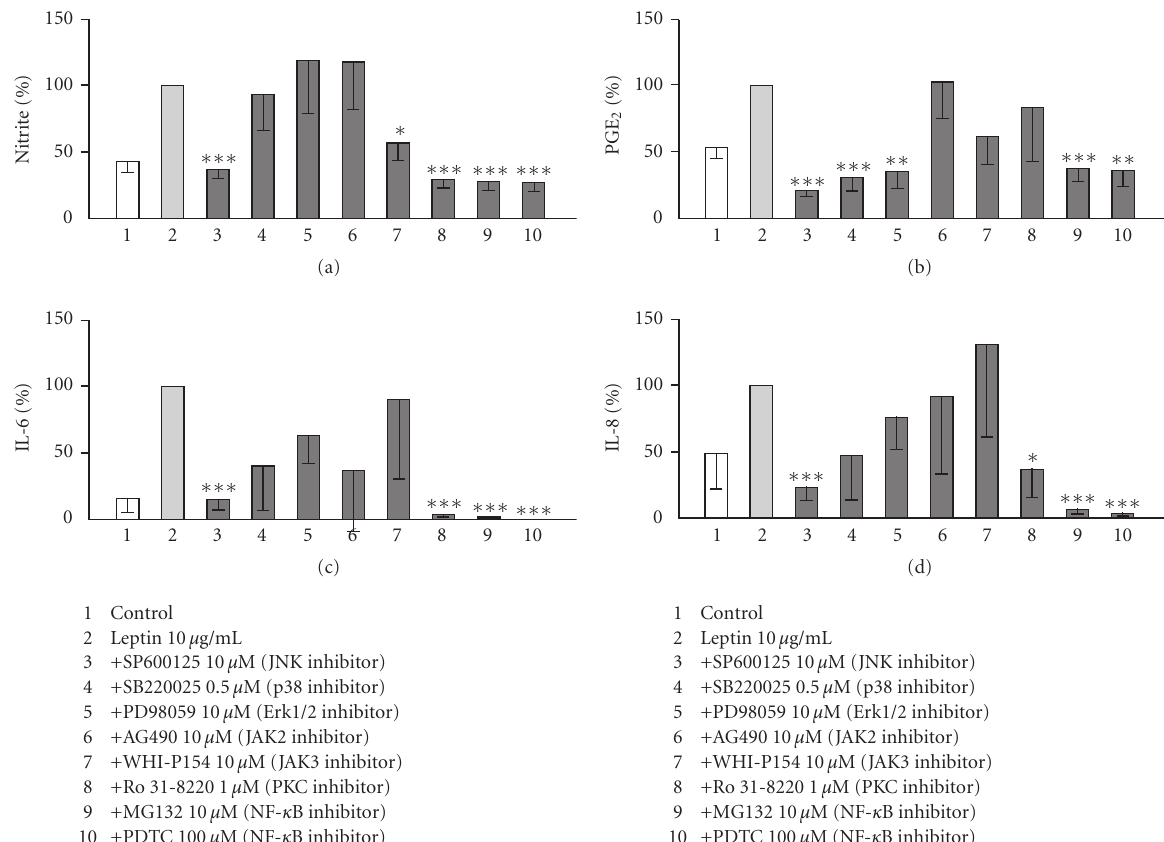
Figure 3: The e ff ects of signaling pathway inhibitors on leptin induced NO (a), PGE 2 (b), IL-6 (c), and IL-8 (d) production in human OA cartilage. Cartilage explants were incubated for 48 hours with leptin (10 μ g/mL) and the inhibitor indicated. NO production (a) was measured as nitrite accumulation in the culture medium by Griess reaction. PGE 2 production (b) in the culture medium was measured by RIA. Levels of IL-6 (c), and IL-8 (d) in the culture medium were measured by ELISA. Leptin-induced NO/PGE 2 /IL-6/IL-8 production was set as 100%, and the other values were related to that. The results are expressed as mean ± SEM. Samples were collected from 7 patients in (a) and (b) ( n = 7) and from 6 patients in (c) and (d) ( n = 6). ∗ : P < . 05, ∗∗ : P < . 01, and ∗ ∗ ∗ : P < . 001 as compared to explants treated with leptin